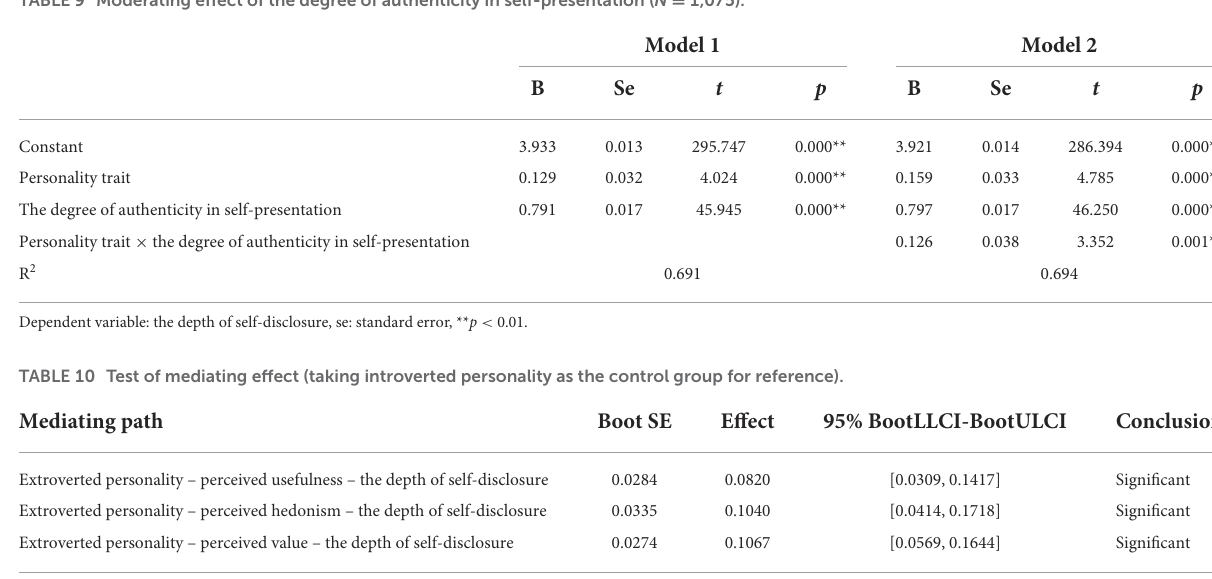
TABLE 9 Moderating effect of the degree of authenticity in self-presentation ( N = 1,075).